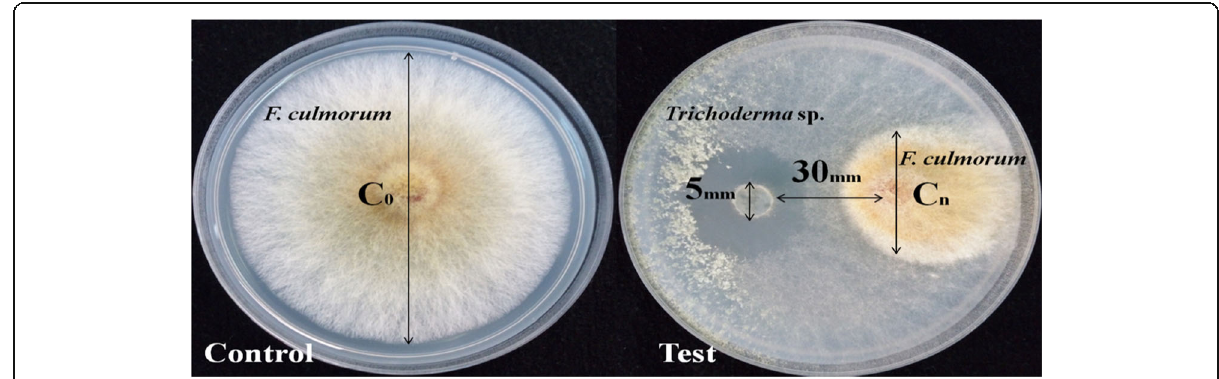
Fig. 1 Demonstrative schema of the different measurements used to calculate the percentage of mycelial growth inhibition for in vitro confrontation Trichoderma/F.